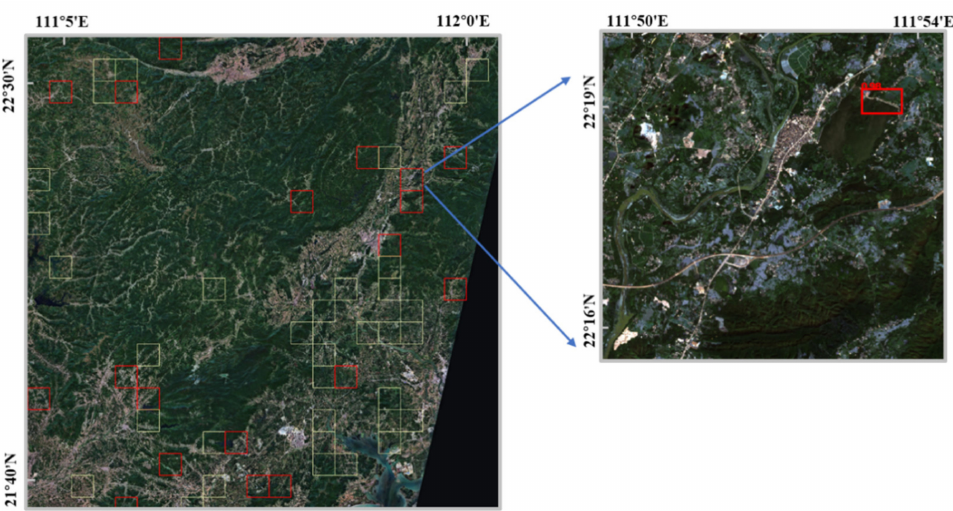
Figure 12. An example of the results from coarse-classification network in single scene images ( left , 10,980 × 10,980 pixels), where red bounding boxes denotes patches correctly classified (TP), yellow bounding boxes denotes patches of false alarm (FP) and they are the retained image patches of the first stage that will be sent to the second-stage network ( right , 512 × 512 pixels).